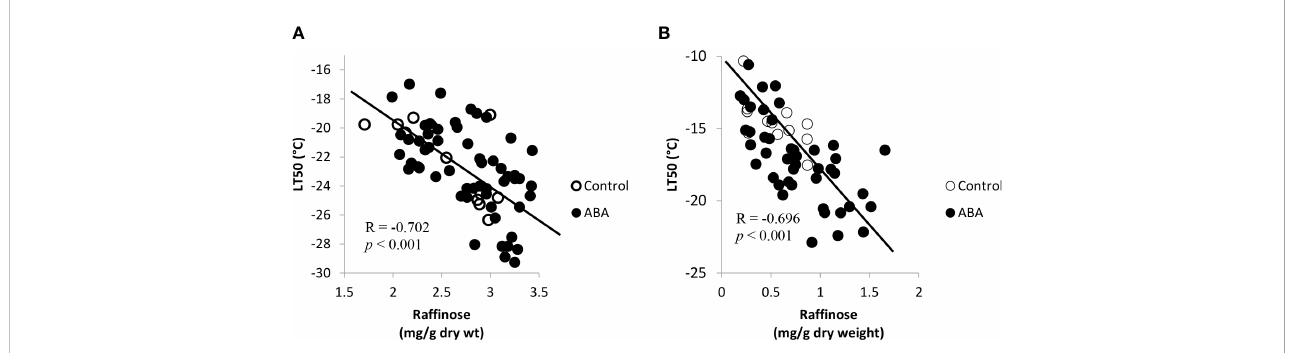
FIGURE 6 Correlations between freezing tolerance (LT50) and the bud raf fi nose concentrations in fi eld grown grapevines during the acclimation stage, October – December for (A) ‘ Chambourcin ’ and October – November for (B) ‘ Cabernet franc ’ . (n =